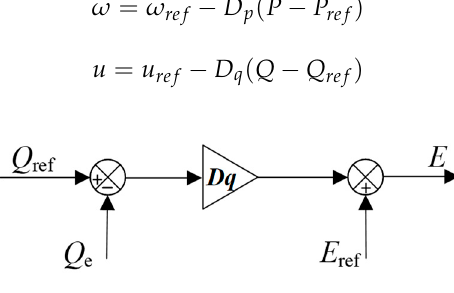
Figure 2. Voltage and reactive power control of VSG.